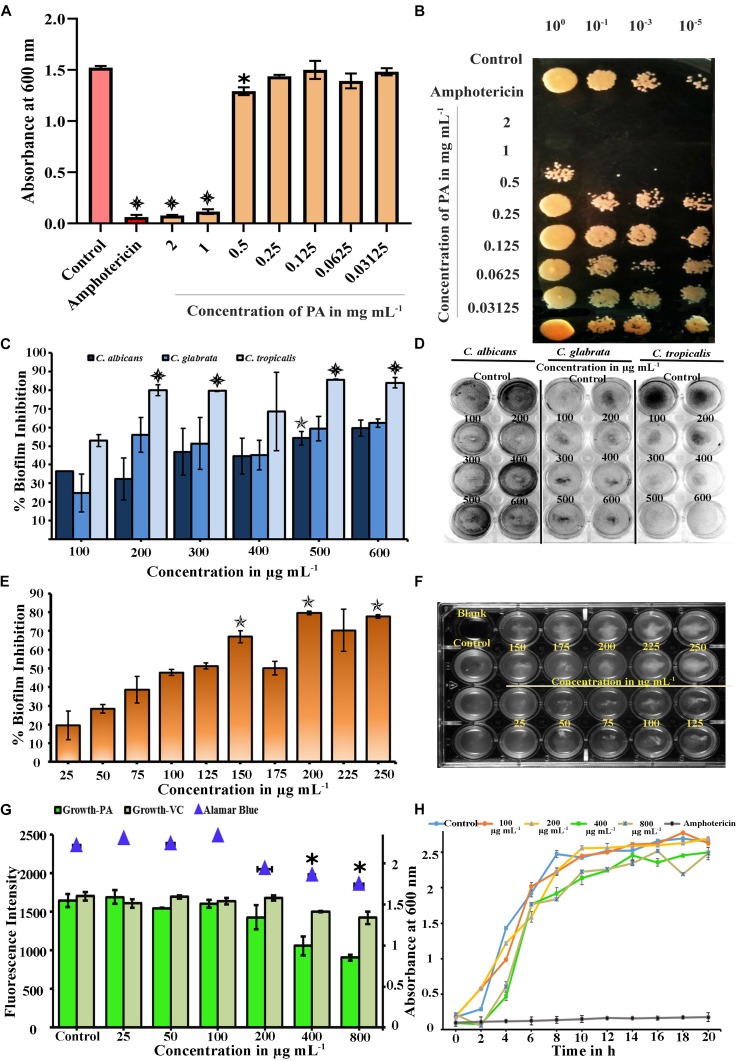
(A) Microbial Inhibitory Concentration (MIC) of PA against C. tropicalis was determined by Broth Dilution assay. PA reduced visible growth of C. tropicalis at 2 (p < 0.001) and 1 mg mL−1 (p < 0.001) and antifungal effect was compared with 10 μg mL−1 of amphotericin (p < 0.001). (B) Effect of PA on growth of Control and PA-treated C. tropicalis after serial dilution and spotting in YEPD agar medium with amphotericin B as positive control (C) Effect of palmitic acid (PA) on Candida species biofilm grown in spider medium. PA decreased the biofilm at 200, 300, 500, and 600 μg mL−1 (p < 0.001) in C. tropicalis and did not inhibit significantly in C. albicans and C. glabrata. (D) Influence of PA on Candida species biofilm stained with CV, a representative image. (E) Inhibitory effect of PA on C. tropicalis biofilm and maximum inhibition was at 200 μg mL−1 (p < 0.01). (F) Representative MTP plate showing biofilm disruption ability of PA. (G) Difference between the impact of PA and its vehicle control on C. tropicalis growth and metabolic activity at different concentrations (25–800 μg mL−1). (H) Growth curve analysis of C. tropicalis with absence and presence of PA (100, 200, 400, and 800 μg mL−1) and 10 μg mL−1 of amphotericin B as positive control. The values are expressed as means and error bars depict standard deviation (n = 6). Significant values were determined by one-way ANOVA in terms of p-value (“✽”, “✯”, and “” denote p < 0.05, p < 0.01, and p < 0.001, respectively) followed by Duncan post hoc test.